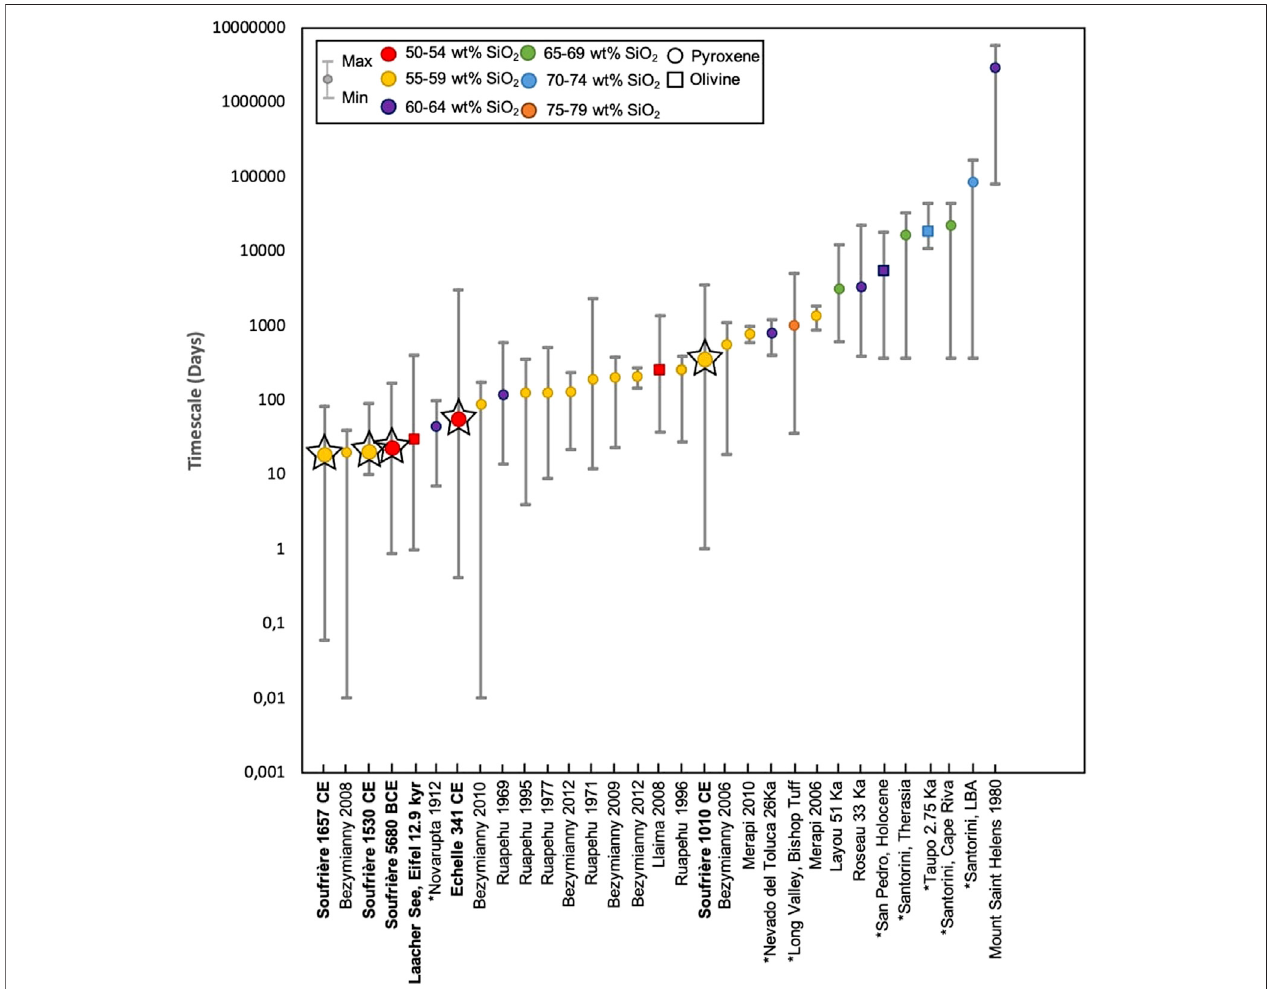
FIGURE 13 | Global database of diffusion timescales (adapted from Costa et al., 2020), for relatively evolved composition eruptions. The majority of studies are done on pyroxene with two examples of olivine studies. This shows the wide range of timescales that can be calculated through diffusion methods, from hours to centuries. Systems incomparable to La Soufrière are marked with an asterisk (*), these systems generally record the longest timescales and are more typically observed in evolved caldera forming systems. The1530 C.E., 1657 Cal. CE and 5680 Cal. BCE (whole rock estimated) eruptions record some of the shortest timescales for systems in a similar compositional range, with timescales most similar to Bezymianny and Novarupta, Alaska, which show similarly short timescales. (Davydova et al., 2018; Boudon et al., 2008; Pichavant et al., 2018; Singer et al., 2016; Ruth et al., 2018; Costa et al., 2013; Weber et al., 2019; Chamberlain et al., 2014; Costa and Chakraborty, 2004; Fabbro et al., 2013; Barker et al., 2016; Flaherty et al., 2018; Kilgour et al., 2014; Gamble et al., 1999; Saunders et al., 2014; Fabbro et al., 2013; Bourgeoisat, 2018; Solaro et al., 2020; Sundermeyer et al., 2020).